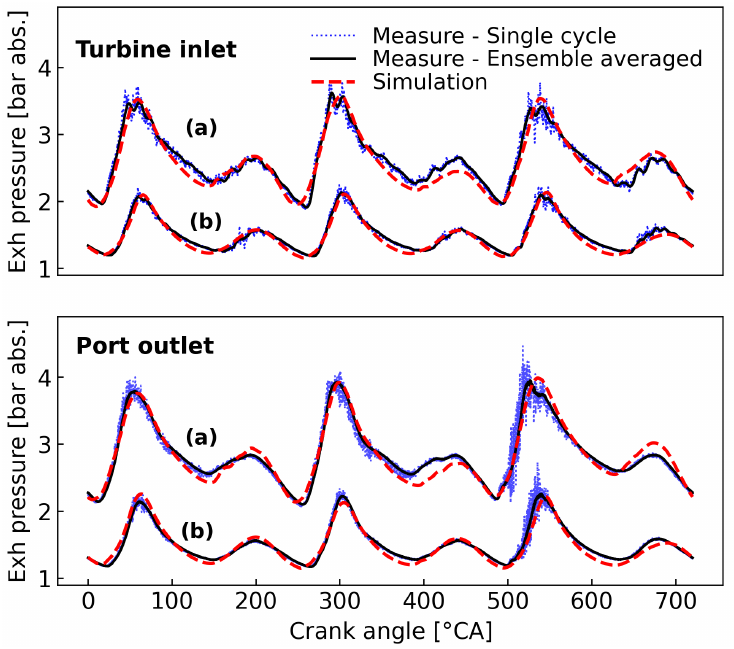
Figure 3. A comparison of crank-angle-resolved exhaust static pressure between fast measurements from engine tests and numerical simulations at engine operating points: (a) 1300 rpm/17.8 nIMEP; (b) 900 rpm/11.5 nIMEP.